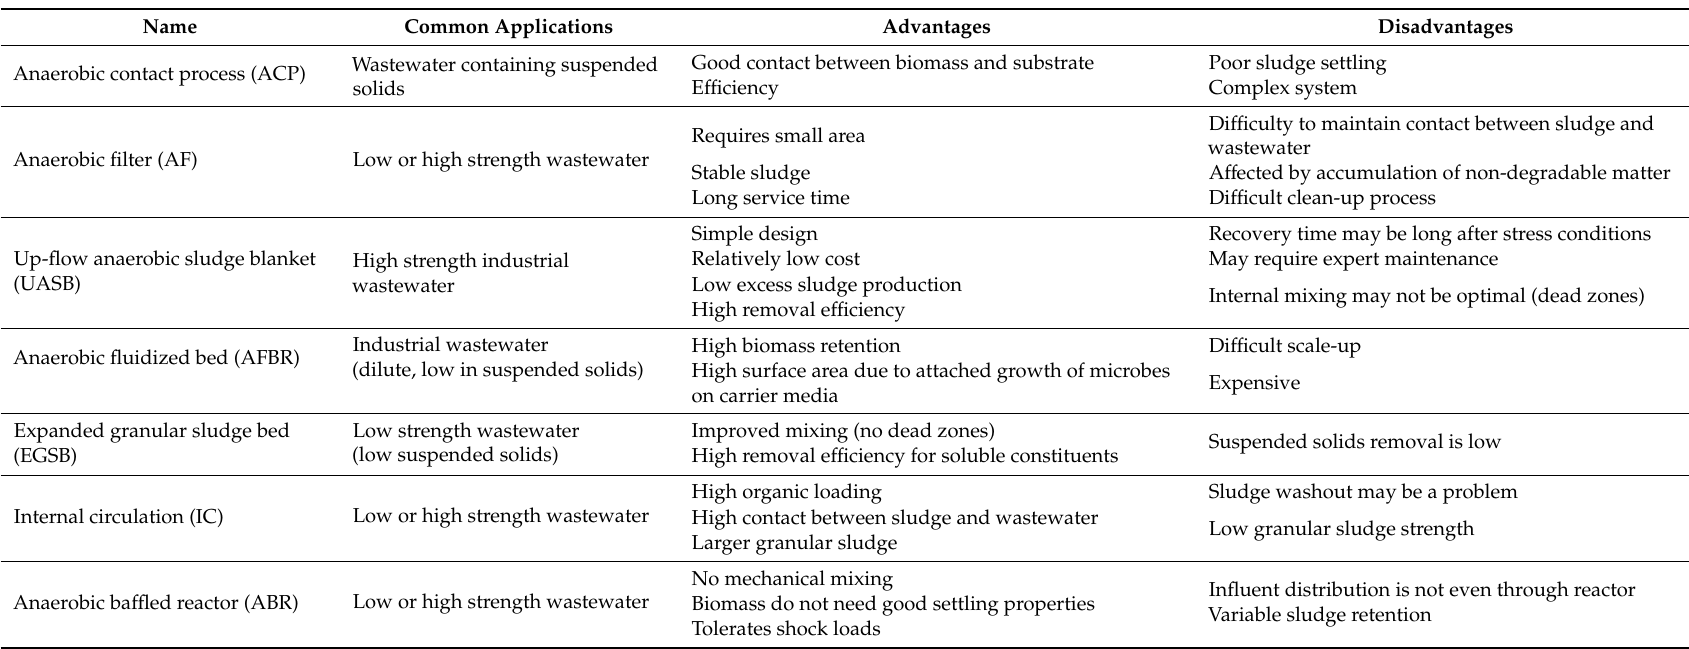
Table 1. Applications, advantages, and disadvantages of commonly used high-rate